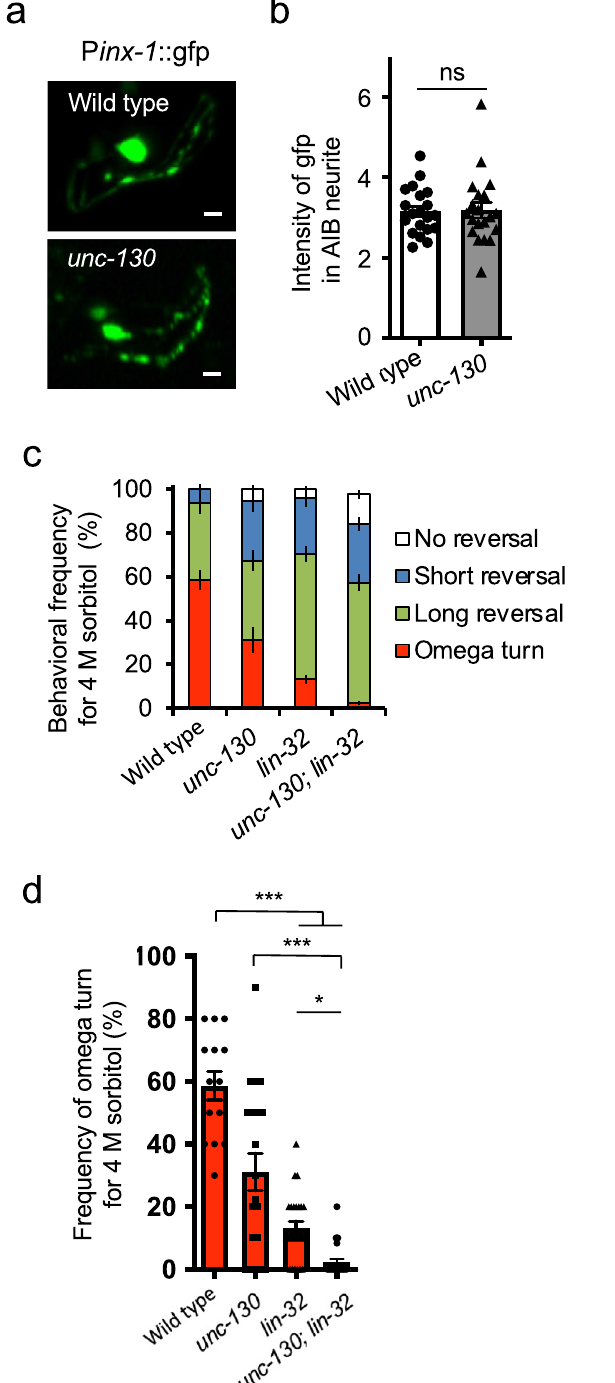
Figure 5. unc-130 does not regulate electrical synapses in the AIBs. ( a ) Comparison of the expression of inx-1 promoter-driven GFP. unc-130 mutants showed similar expression levels. Scale bar = 5 µm. ( b ) There were no differences in the intensity of inx-1 promoter-driven GFP expression measured in cell bodies between the wild-type animals and the unc-130 mutants. “ns” indicates no significant difference ( P = 0.960, n = 20, 20, Mann– Whitney test). ( c ) The double mutants of unc-130 and lin-32 almost completely lacked turn behavior (n = 26), whereas unc-130 and lin-32 single mutants exhibited moderately lower turn frequencies (n = 19, 25) than wild-type animals (n = 14). Each mutant had an increased reversal frequency instead of exhibiting turning. ( d ) unc-130 and lin-32 single mutants (n = 19, 25) showed significantly different turn frequencies than the wild-type animals (n = 14) and the double mutants (n = 26). *** indicates P < 0.001, * indicates P < 0.05 (Kruskal–Wallis test with Dunn’s multiple comparisons test as a post hoc test). The error bars in these figures represent the ± SEM